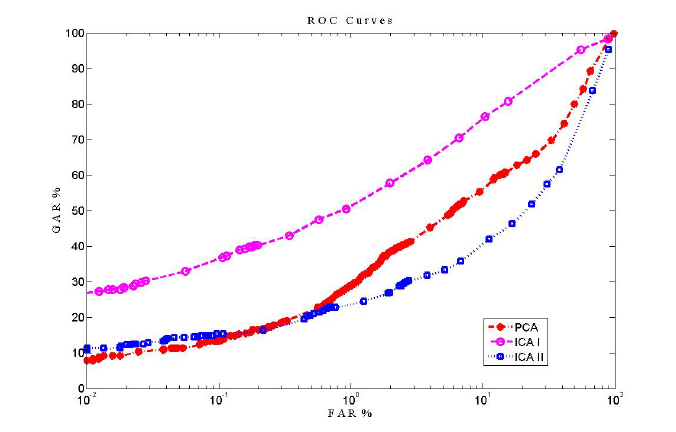
Figure 7. ROC curves for conventional methods on Database II.